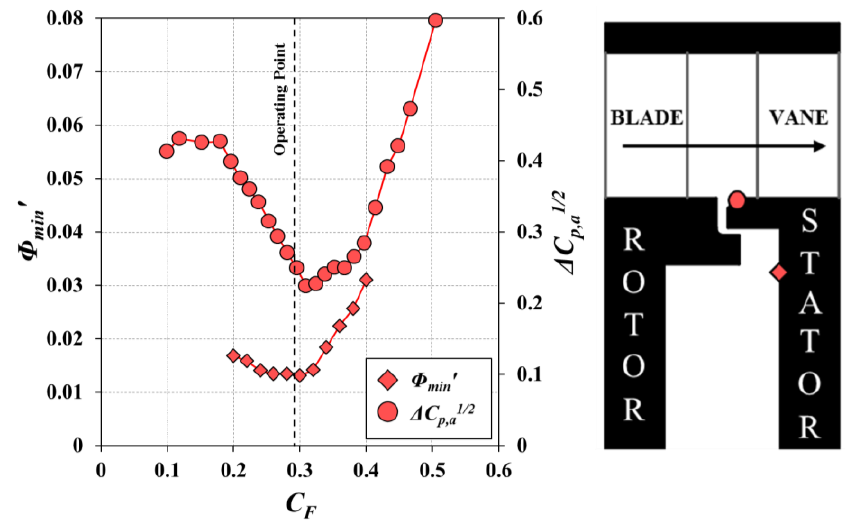
Figure 13. Effect of flow coefficient C F on Φ min ’ and Δ C p,a 1/2 for the single radial-clearance seal in the downstream wheel-space at r / b = 0.958 and annulus at location A3 ( Re φ = 7.2 × 10 5 ).